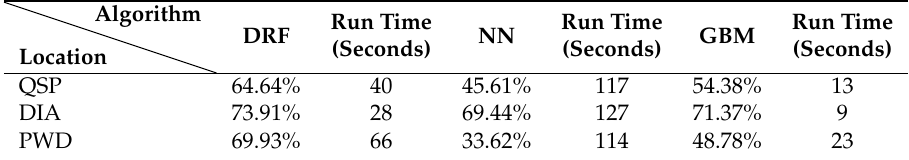
Table 3. Accuracy and average run time